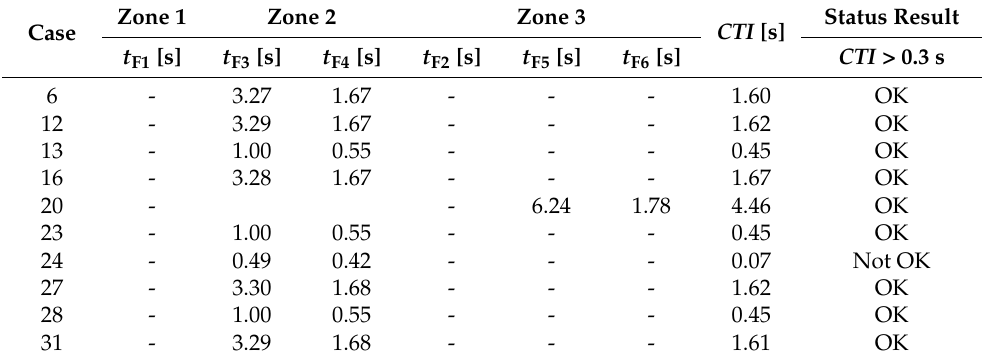
Table 9. IEEE 13-bus feeder system (Figure 6), simulated considering PQ nodes. Fuse coordination results (tripping times) and compliance in cases where two consecutive fuses tripped (see Table